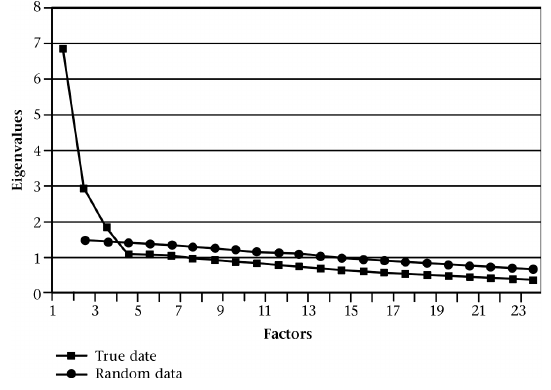
Figure 2: Scree plot first language T ABLE 7 R OTATED PATTERN MATRIX FOR SECOND AND FIRST LANGUAGE RESPONDENTS ( THREE FACTOR SOLUTION ) Second langiage